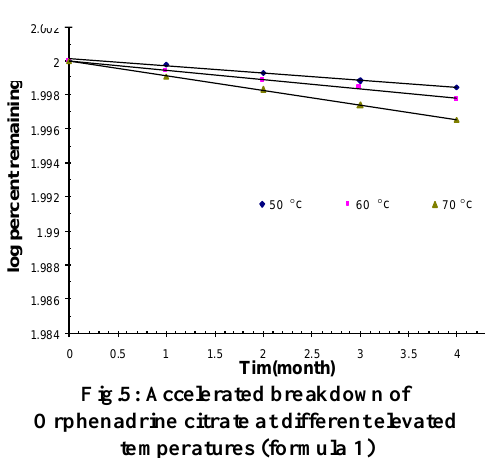
Fig.5: Accelerated breakdown of Orphenadrine citrate at different elevated temperatures (formula